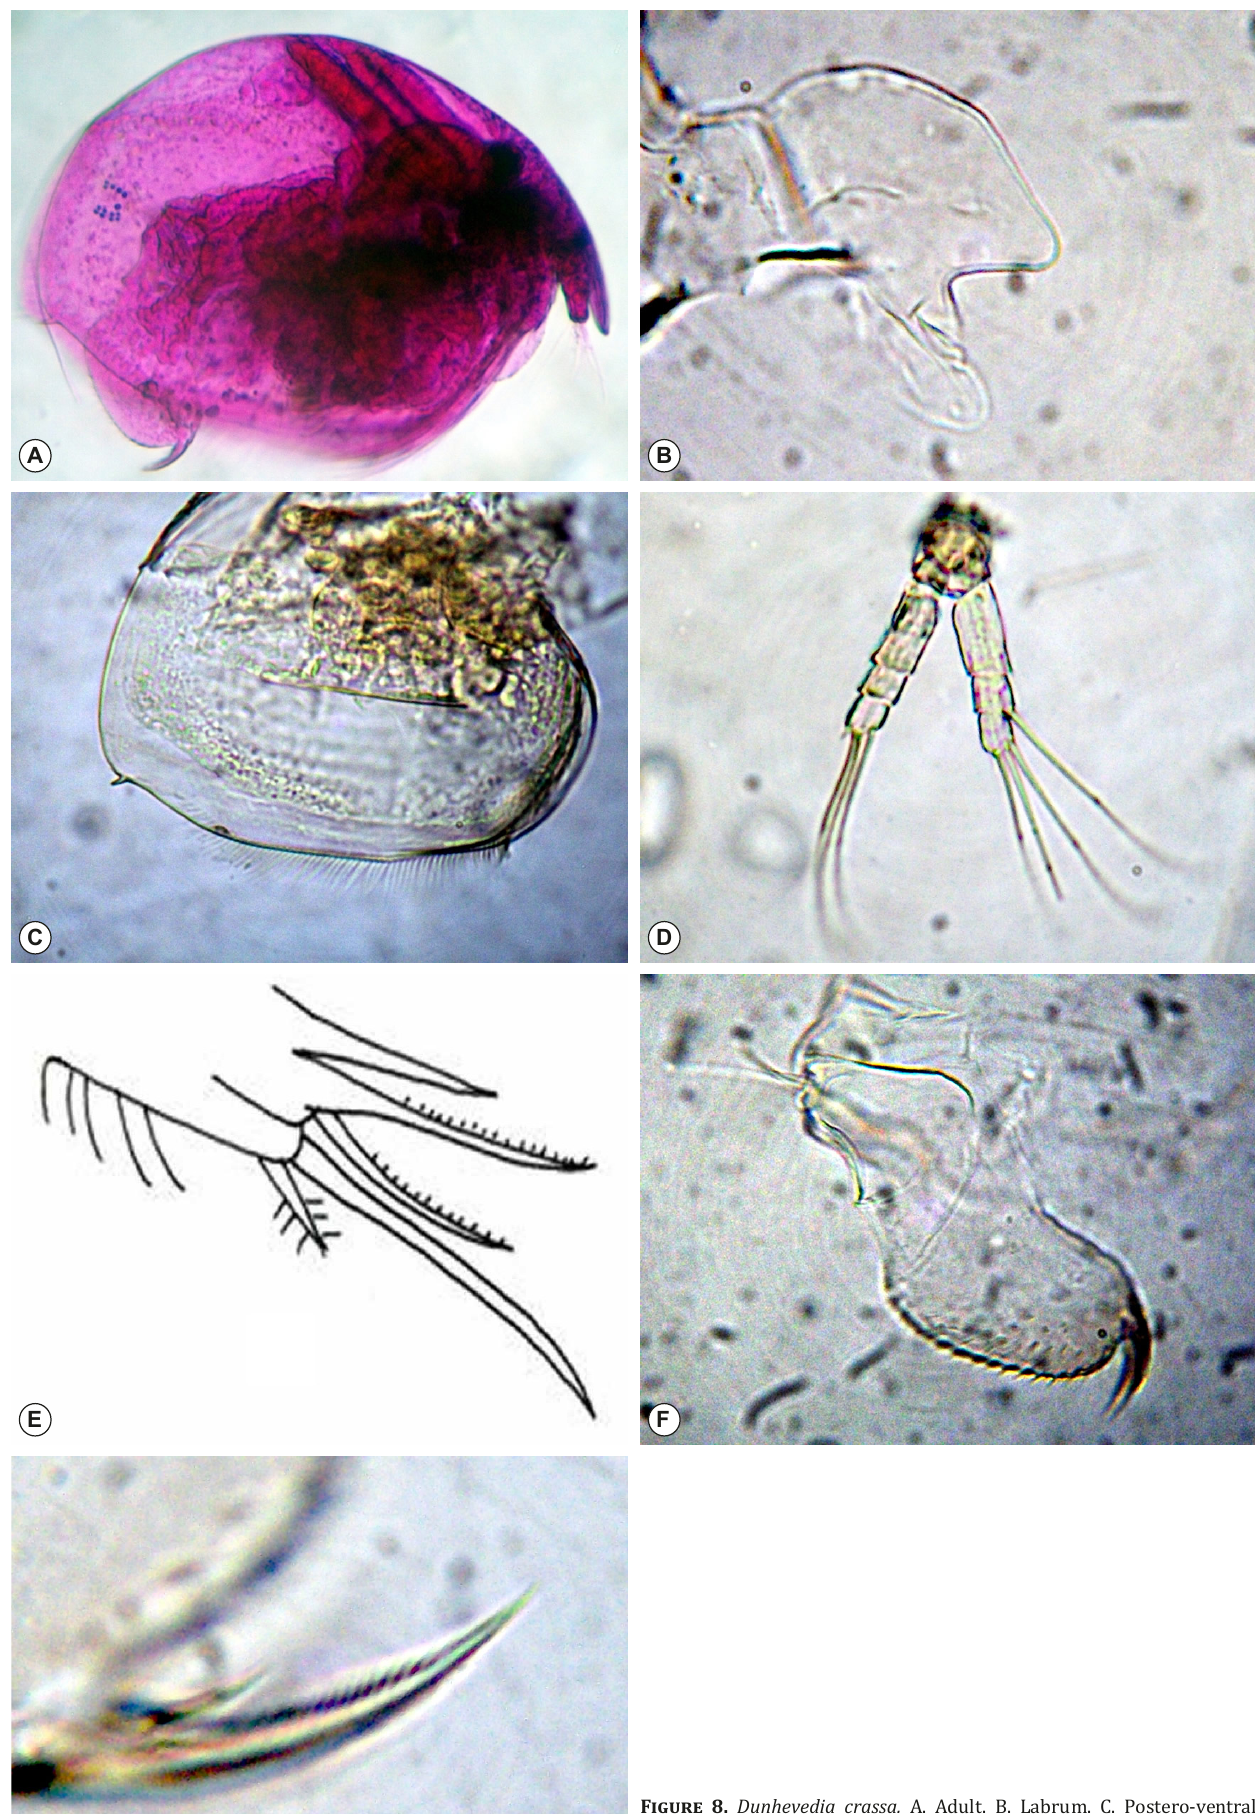
Figure 8. Dunhevedia